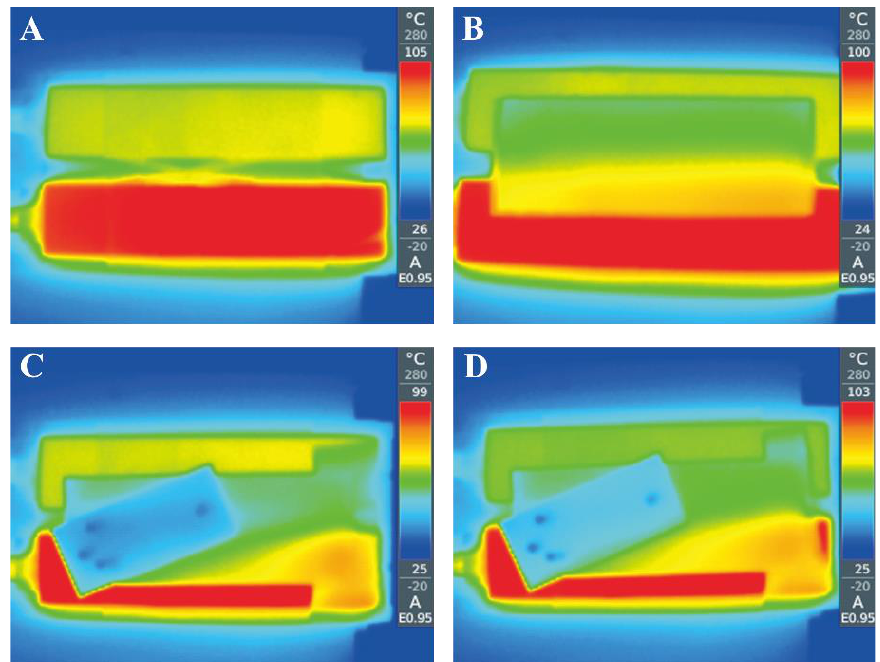
Figure 4. ( A ) The temperature distribution of the heating aluminum block; ( B ) the temperature dis- tribution of the CF-PCR chip after heating on the aluminum block; ( C ) the temperature